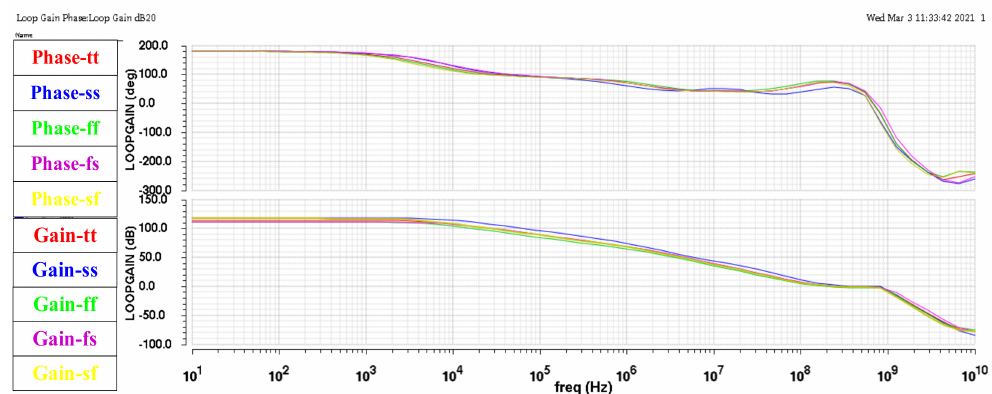
Figure 13. The simulated bode diagrams of the DLAFC configuration under 5 different process corners.